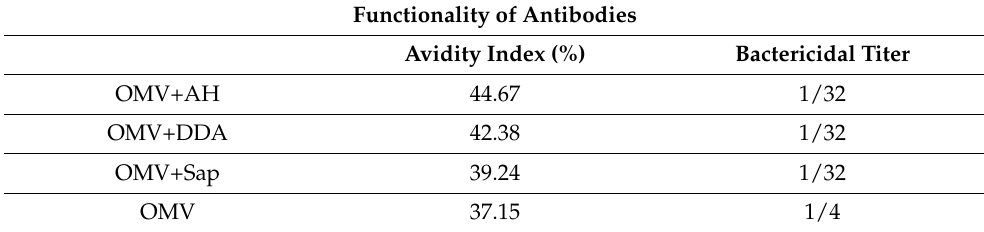
Table 4. Functional parameters of antibodies in sera of young mice, collected after the whole immunization